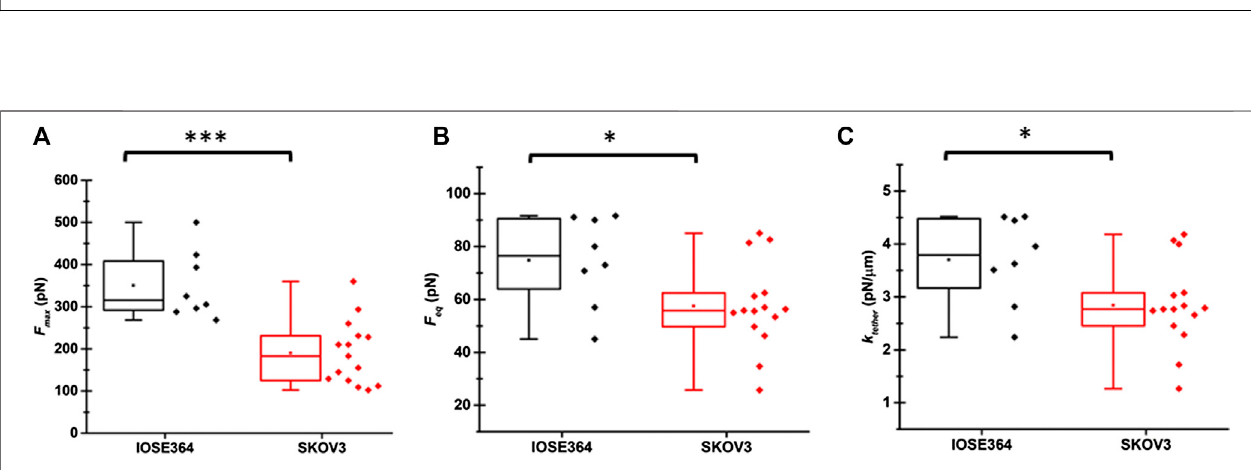
Frontiers in Physics |